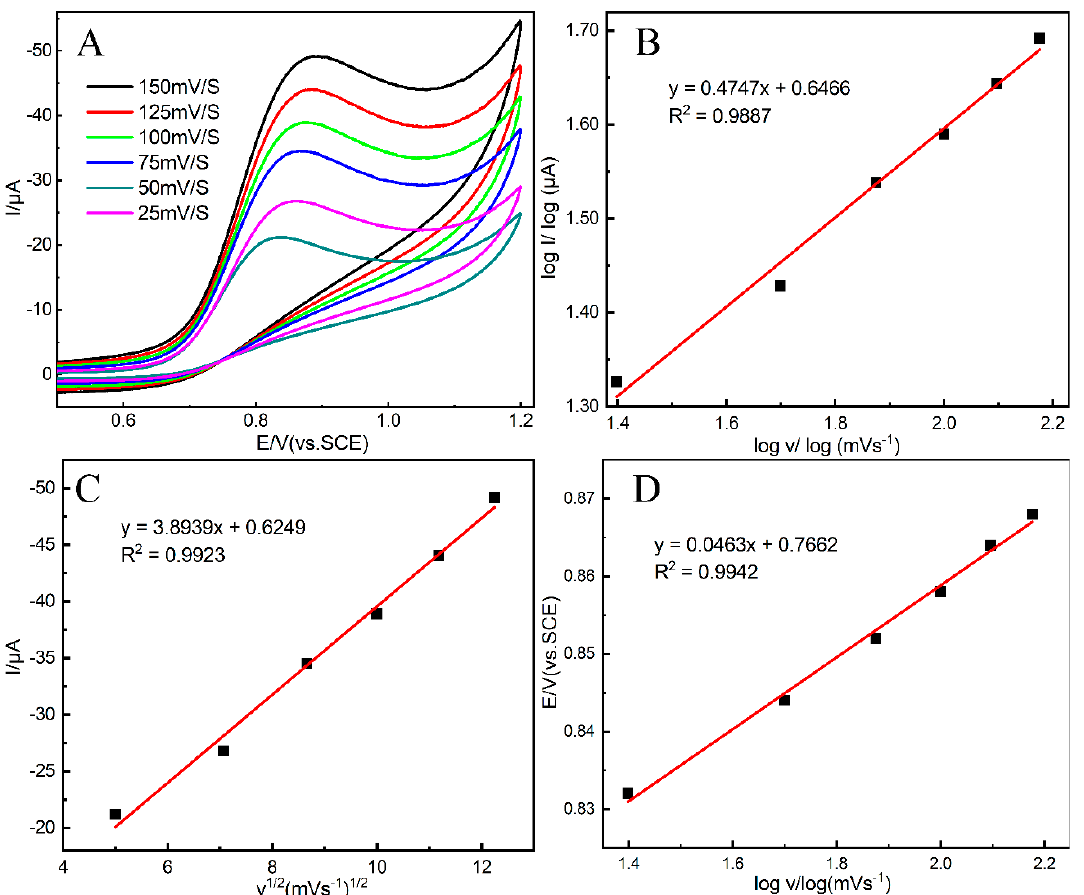
Figure 6. ( A ) CV curves in 0.1 M PBS with 500 μ M nitrite under different scan rates, ( B ) the linear relationship of log current (I) and log scan rate (v), ( C ) the linear relationship of log current (I) and the square root of scan rate (v), and ( D ) the linear relationship of response potential and log scan rate (v).